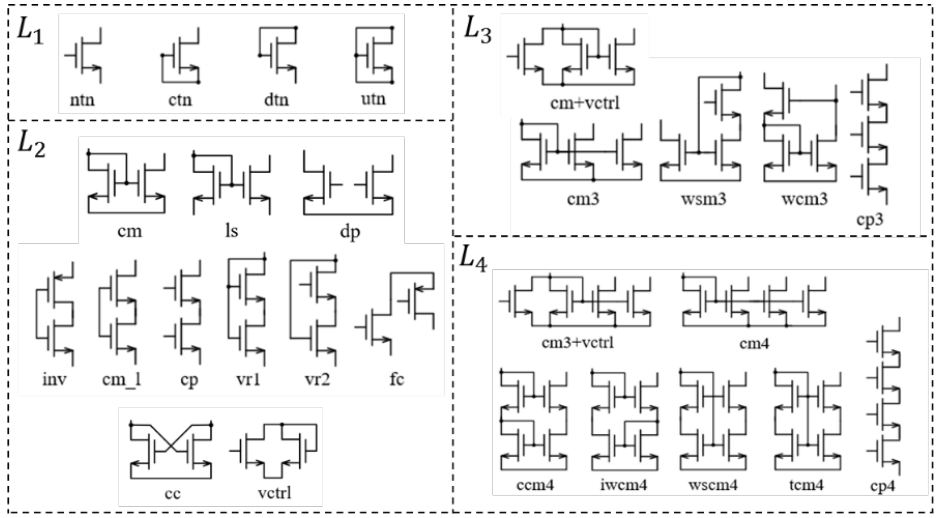
Figure 9. Illustration of building block library.